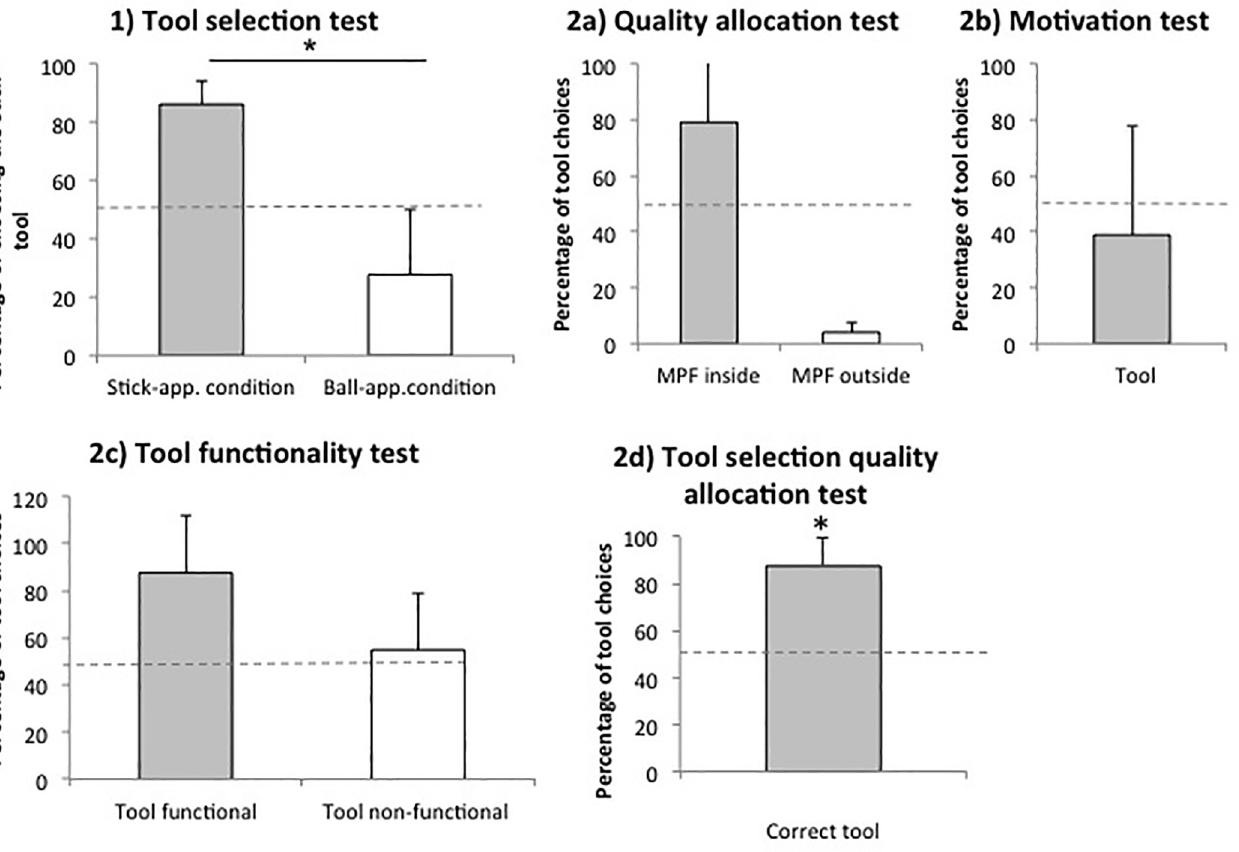
Fig 3. Mean percentages of tool choices per condition within each test. 1) TST (Tool selection test) , 2a) MT (Motivation test) , 2b) QAT (Quality allocation test) , 2c) TFT (Tool functionality test) , 2d) TSQAT (Tool selection quality allocation test) ; (n = 6). � p < 0.05.